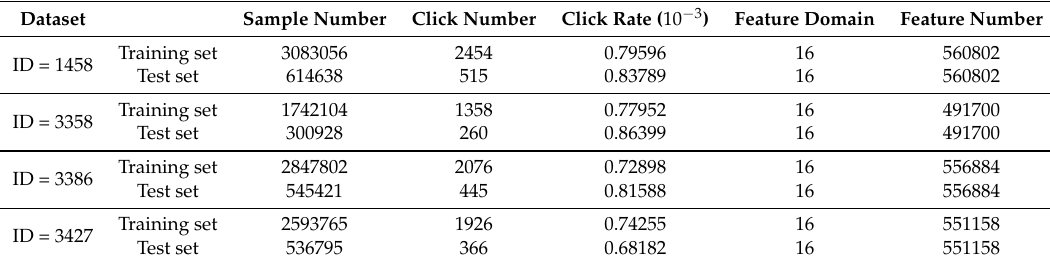
Table 1. The statistics of four datasets of